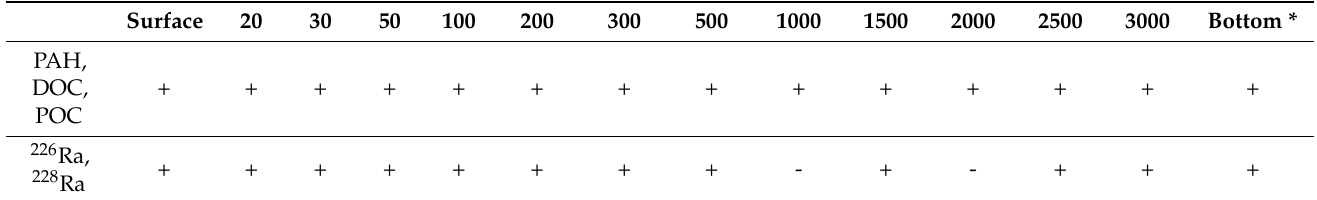
Table 1. Depths (m) where the samples for polycyclic aromatic hydrocarbon (PAHs), Ra isotopes and dissolved and particulate organic carbon (DOC and POC) analysis were